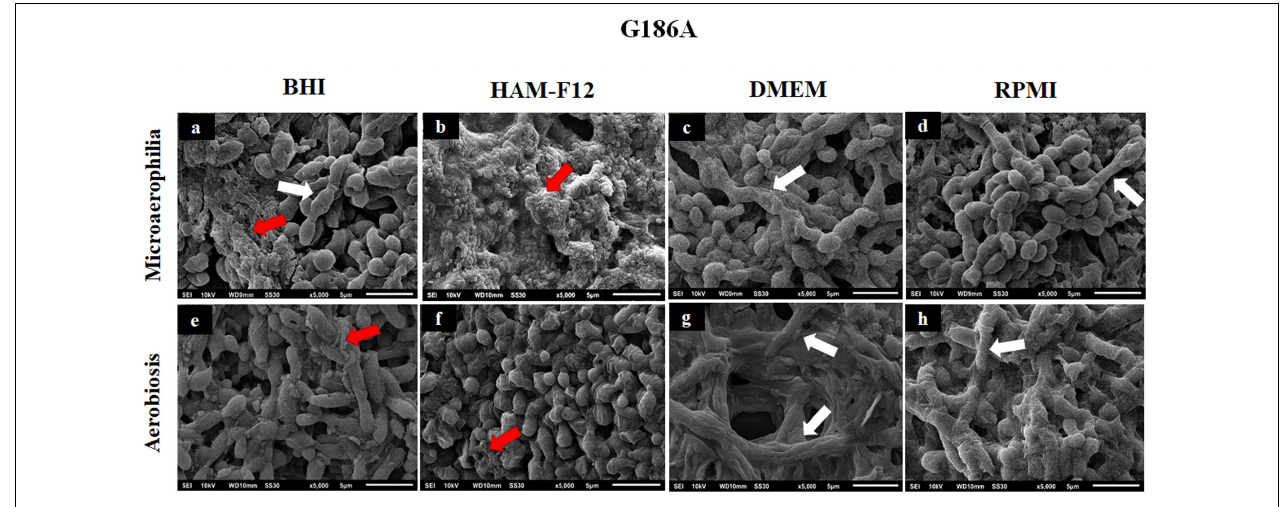
FIGURE 8 | Scanning electron microscopies of the biofilm of Histoplasma capsulatum formed by strain G186A in different culture media in the conditions of microaerophilia (a–d) and conditions aerobiosis (e–h) . The red arrows denote the extracellular matrices, while the white arrows denote some